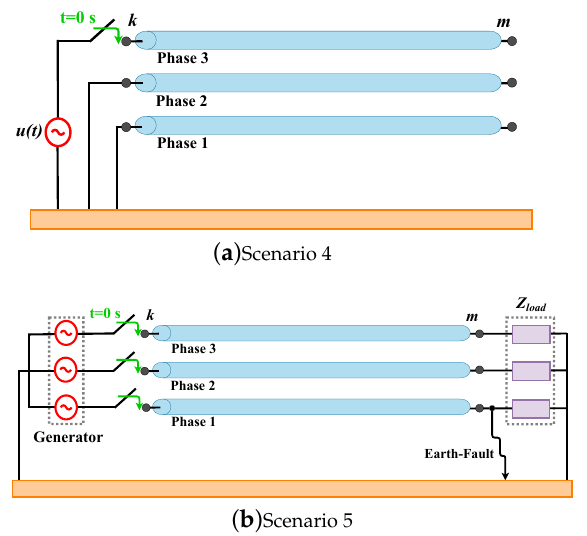
Figure 13. Layouts of the three-phase TL for an: ( a ) open-circuit test; ( b ) fault test.